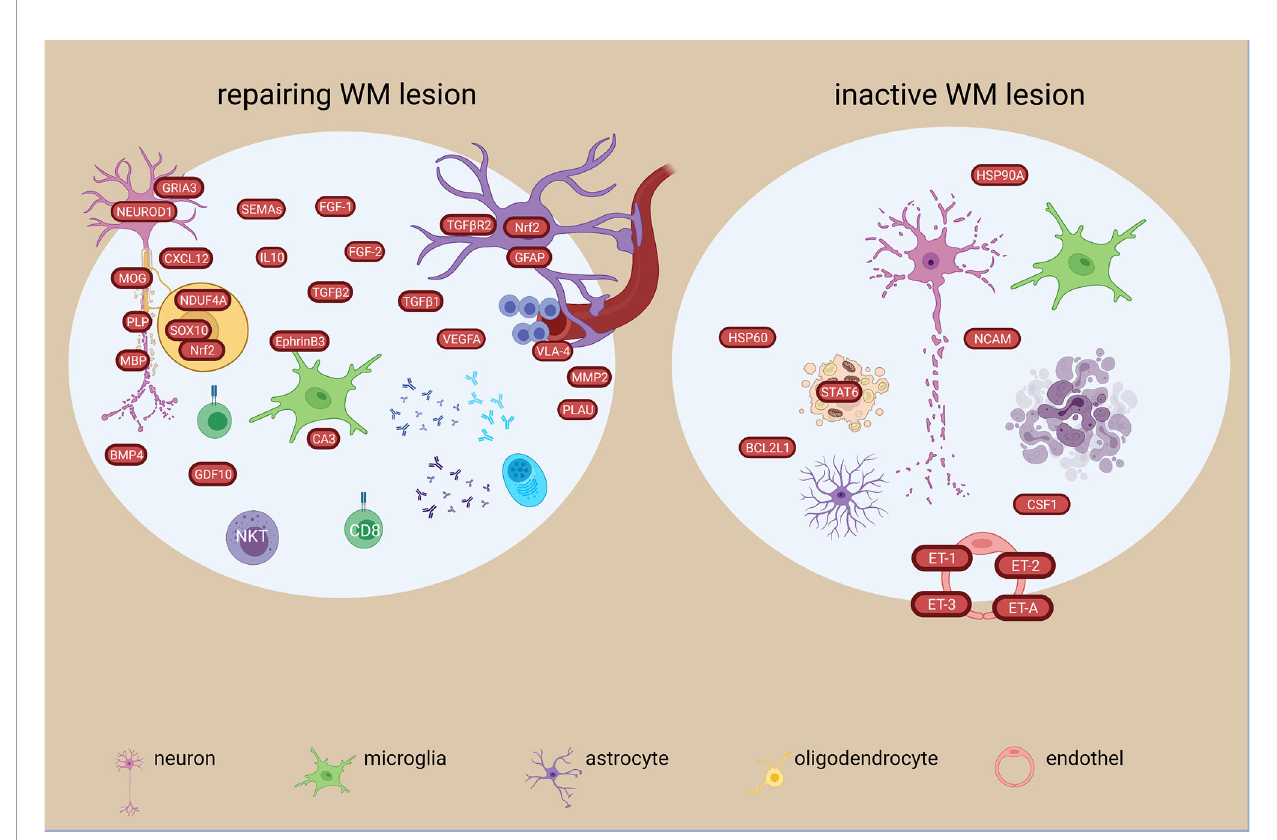
FIGURE 5 | Signatures of repairing/remyelinating and inactive WM lesion types in the MS brain based on transcriptome and proteome studies. Remyelinating signatures are characterized among others by soluble growth factors and reparatory molecules such as FGF-1, -2, TGFB1,-2, BMP4 and GDF10. Oxidative and anti- oxidative responses are present, as well as a heterogenous immune response. In the inactive lesion, different heat shock proteins are present together with changes in endothelin transcripts. The fi gure was created by compiling data from several articles, and therefore molecules may not be expressed at the same time. Created with